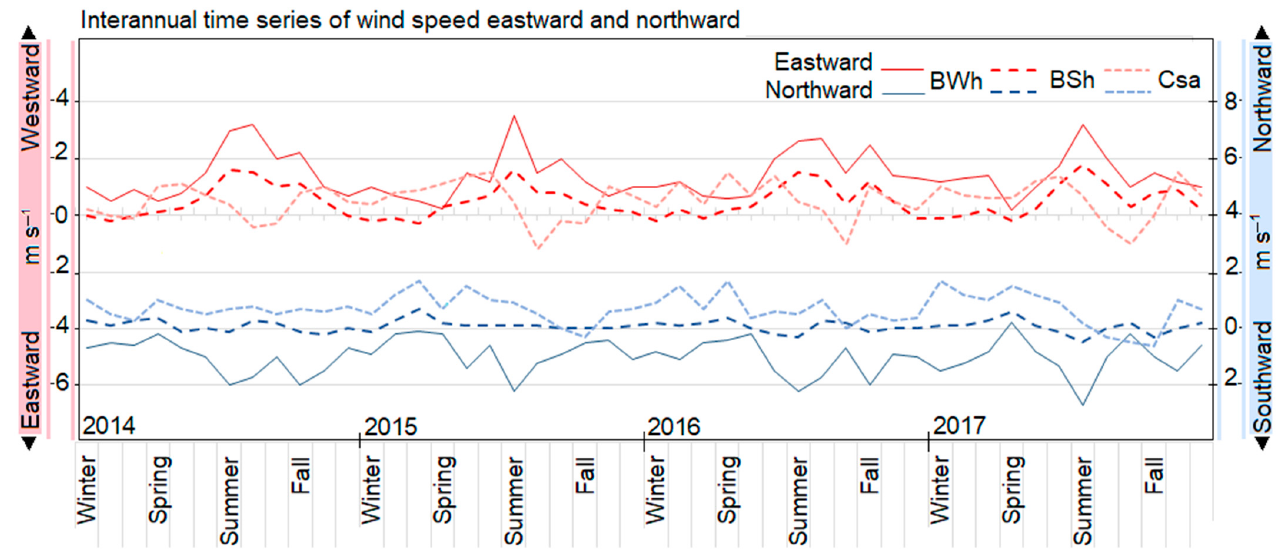
Figure 6. Interannual time series of predominate wind speeds in eastward and northward directions. Eastward wind and southward wind direction are pronounced on the left (reddish trend) and right (bluish trends) vertical axis. Solid lines, big and small dashed lines represent interannual time series of windspeed in BWh, BSh, and Csa climate zone respectively.